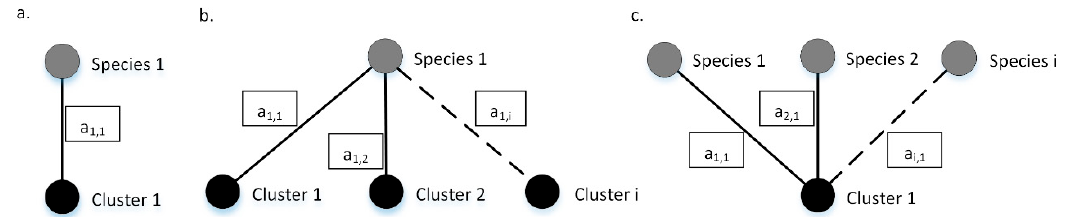
Figure 2. Example graphs. Species (in gray) and the corresponding clustering groups (in black) are connected through weighted edges. ( a ) All the a1,1 records identified as specimens of Species 1, are grouped on Cluster 1 and vice versa; ( b ) Species 1 contains a1,1, a1,2, and a1,i specimens grouped on clusters 1, 2,..., i, respectively; ( c ) Cluster 1 contains a1,1, a2,1, and ai,1 specimens of species 1, 2, and i, respectively. Dashed lines represent connections that may exist but are not mandatory to describe the example. The values inside each box represents edges weights.